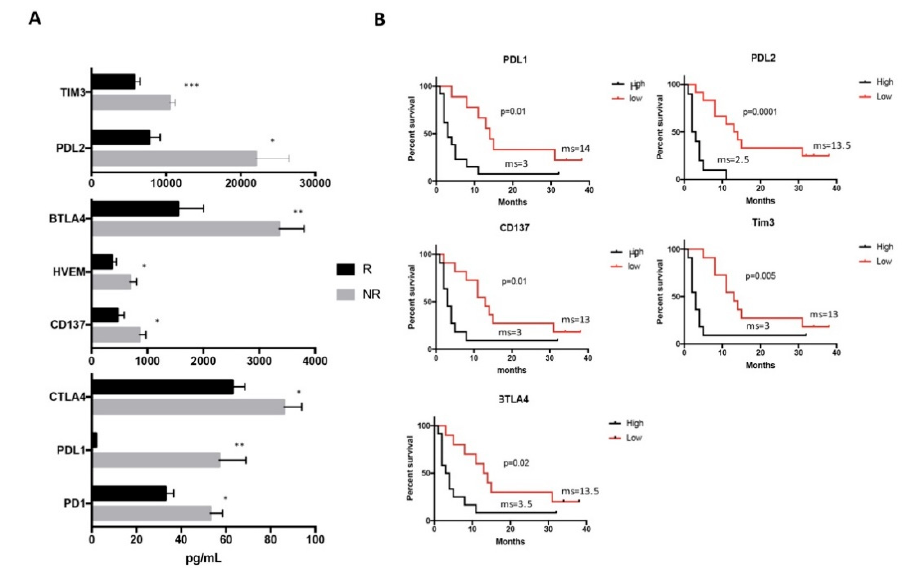
Figure 2. Levels of sICs evaluated in R and NR patients at first clinical evaluation (>T0) and their correlation with duration of response. ( A ) Soluble immune checkpoint ‐ related molecules were evaluated in the serum of responding (R, black histograms) and non ‐ responding (NR, black histograms) patients after three months of the beginning of Nivolumab treatment by Luminex multiplex assay. Histograms represent the concentration mean values ± SEM of PD1 (R 31 ± 4 pg/mL vs. NR 53 ± 6 pg/mL), PDL1 (R 1.7 ± 0.06 pg/mL vs. NR 57 ± 12 pg/mL), CTLA4 (R 61 ± 5 pg/mL vs. NR 86 ± 8 pg/mL), CD137 (R 429 ± 113 pg/mL vs. NR 859 ± 117 pg/mL), HVEM (R 332 ± 82 pg/mL vs. NR 687 ± 124 pg/mL), BTLA4 (R 1.4 ± 0.4 ng/mL vs. NR 3.3± 0.4 ng/mL), PDL2 (R 7.3 ± 1.4 ng/mL vs. NR 22 ± 4.4 ng/mL) and Tim3 (R 5.4 ± 0.8 ng/mL vs. NR 10 ± 0.7 ng/mL) at >T0. A Student’s unpaired t ‐ test was used to compare the difference between R and NR patients. p values ≤ 0.05 were considered significant. * p < 0.05, ** p < 0.01, *** p < 0.001. ( B ) Survival analysis carried out at >T0 in NSCLC patients with high and low levels of sICs. The concentration median values of PDL1, PDL2, CD137, Tim3 and BTLA4 were used to define patients with high and low levels of sICs. The concentration median values are the following: PDL1 (20 pg/mL), PDL2 (7.7 ng/mL), CD137 (624 pg/mL), Tim3 (8.1 ng/mL) and BTLA4 (2.2 ng/mL). Long ‐ rank tests were used to compare the duration of response between the two groups. ms = median survival.